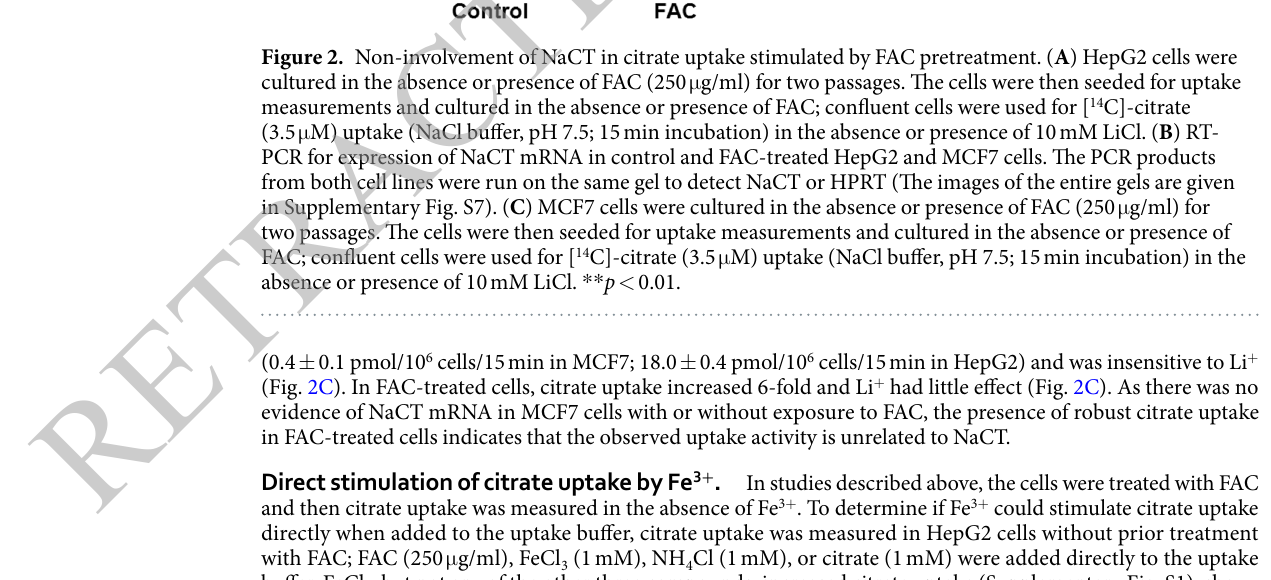
(Fig. 2C). In FAC-treated cells, citrate uptake increased 6-fold and Li + had little effect (Fig. 2C). As there was no evidence of NaCT mRNA in MCF7 cells with or without exposure to FAC, the presence of robust citrate uptake in FAC-treated cells indicates that the observed uptake activity is unrelated to NaCT. Direct stimulation of citrate uptake by Fe 3 + . In studies described above, the cells were treated with FAC and then citrate uptake was measured in the absence of Fe 3 + . To determine if Fe 3 + could stimulate citrate uptake directly when added to the uptake buffer, citrate uptake was measured in HepG2 cells without prior treatment with FAC; FAC (250 μ g/ml), FeCl 3 (1 mM), NH 4 Cl (1 mM), or citrate (1 mM) were added directly to the uptake buffer. FeCl 3 , but not any of the other three compounds, increased citrate uptake (Supplementary Fig. S1), show- ing the direct stimulatory effect of Fe 3 + on citrate uptake. It was also important to note that pretreatment with FAC stimulated [ 14 C]-citrate uptake (Fig. 1C) whereas it did not have any effect when added directly to the uptake medium (Supplementary Fig. S1). The most likely explanation for this difference is the fact that FAC is a complex of Fe 3 + , NH 4 + , and citrate, and therefore the unlabeled citrate suppresses [ 14 C]-citrate by competition in spite of the presence of Fe 3 + . This is not the case when cells are exposed to FAC only during pretreatment but not during uptake.